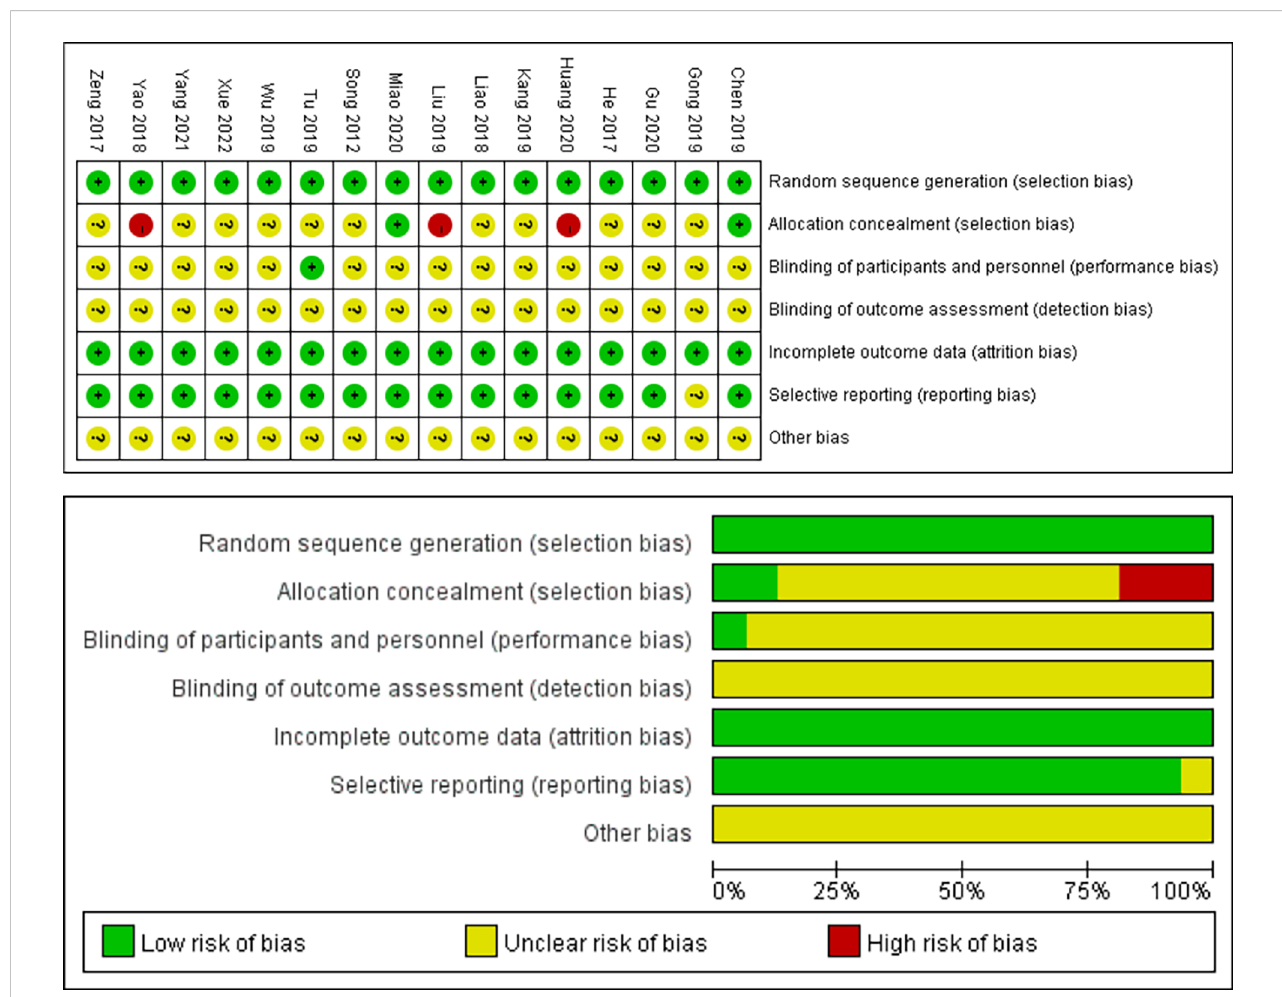
summary showed that the postoperative hospital stay was signi fi cantly shorter by 2.88 days in the ERAS group compared with the routine care group (WMD=-2.88, 95% CI: -3.71 to -2.05, p<0.001, I 2 = 99.0%) (Figure 3A). Subgroup analysis by surgical approach showed that the postoperative hospital stay was reduced by 2.09 days (WMD=-2.09, 95% CI: -3.37 to -0.80, p<0.001, I 2 = 97.7%) in the subgroup of robot- assisted laparoscopic surgery (Figure 1 in Supplementary Data Sheet 1); the postoperative hospital stay was reduced by 3.00 days in the